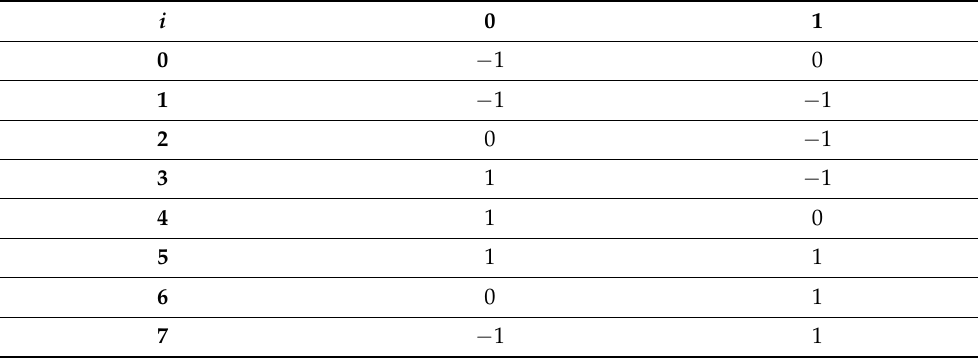
Table 1. Moore-neighbor vector ( N m ). i is the index of the neighbor pixel (0 to 7) total 8. 0 is the relative shift in the x-axis, and 1 is the relative shift in the y-direction.